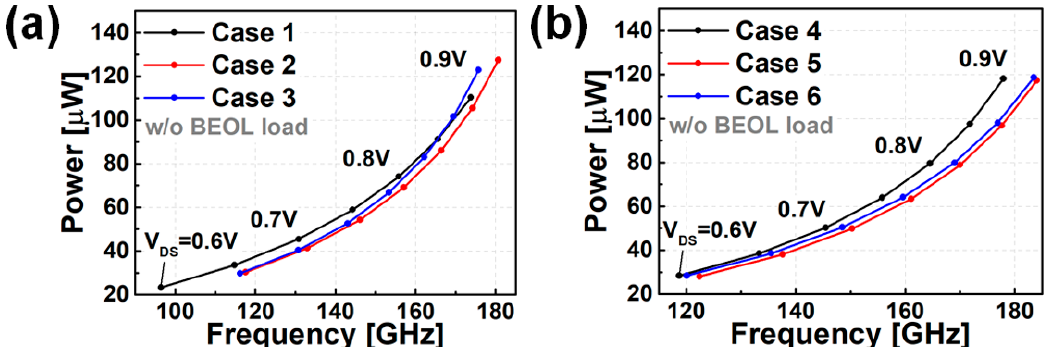
Figure 7. PPA results of nine stages RO (without BEOL) for ( a ) without BO models (case 1–3), ( b ) with BO models (case 4–6).